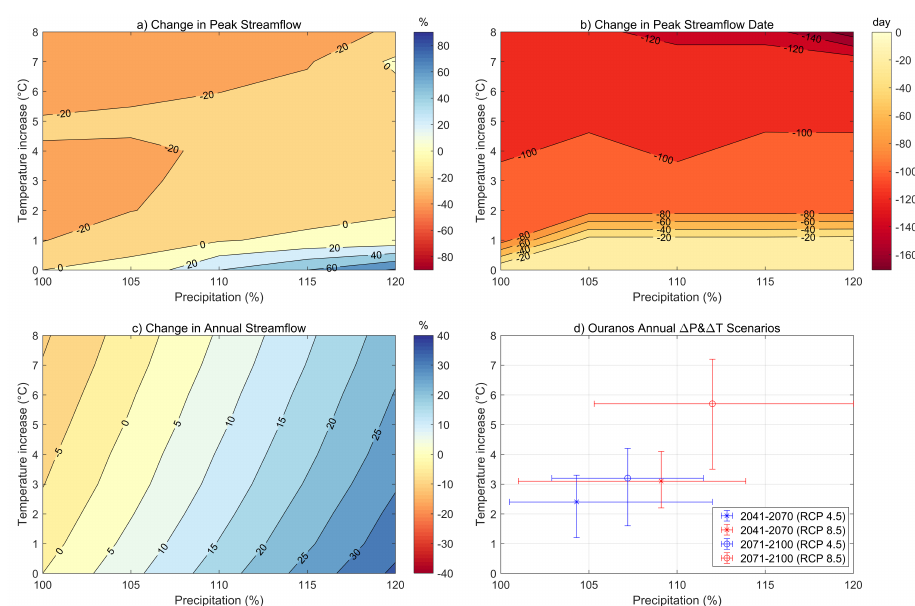
Figure 12. Climate sensitivity of streamflow in Acadie River. ( a ) Changes in annual peak daily discharge; ( b ) changes in annual peak daily discharge date; ( c ) changes in annual total discharge in response to temperature and precipitation changes; and ( d ) projected changes in annual temperature and precipitation for the periods 2041–2070 and 2071–2100 under a moderate emission scenario (RCP 4.5) and a high emission scenario (RCP 8.5) for Mont é r é gie region of Qu é bec